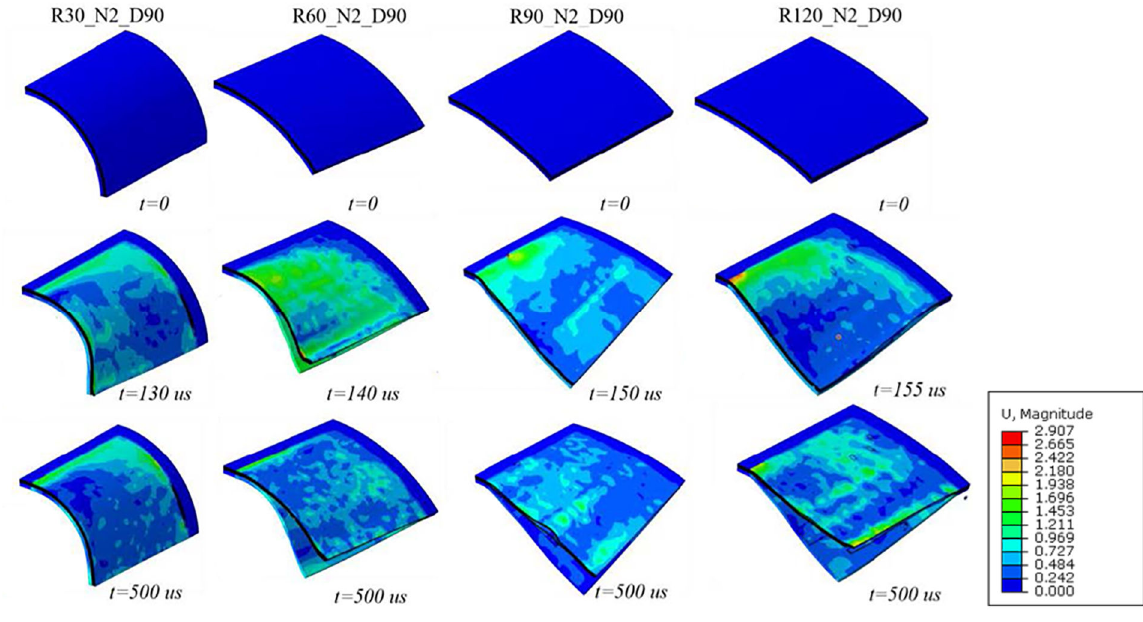
Figure 12. Deformation–time history diagram of double-layer CARALL structures with different radii of curvature.